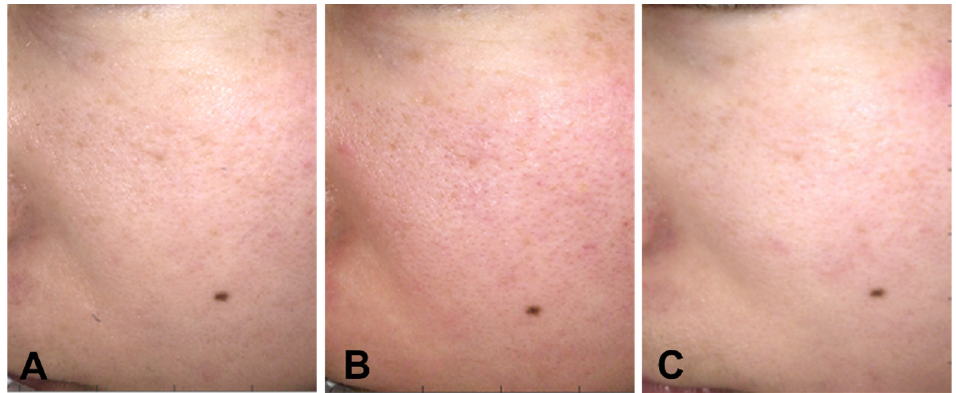
Figure 4. Case 1. Facial images taken after face washing in the morning. ( A ) Final day of non-mask period (phase I), ( B ) Final day of mask period (phase II), ( C ) Final day of GFF Pitera™ + mask period (phase III).